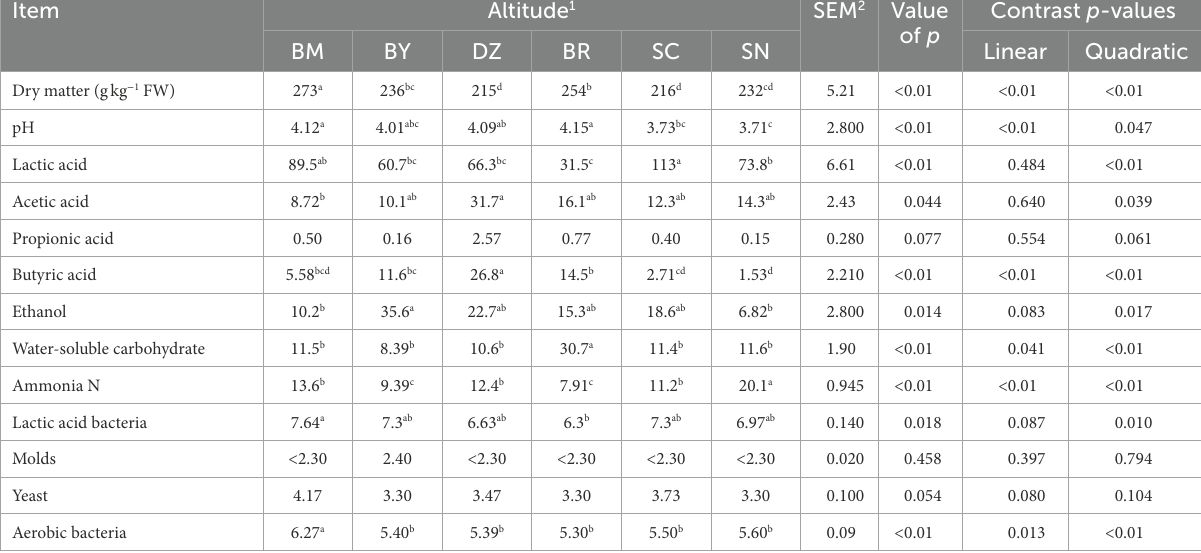
TABLE 2 The chemical composition, fermentation quality (g/kg DM basis unless stated otherwise), and microbial populations (log 10 cfu/g FW) of ensiled oat ( Avena sativa L.).